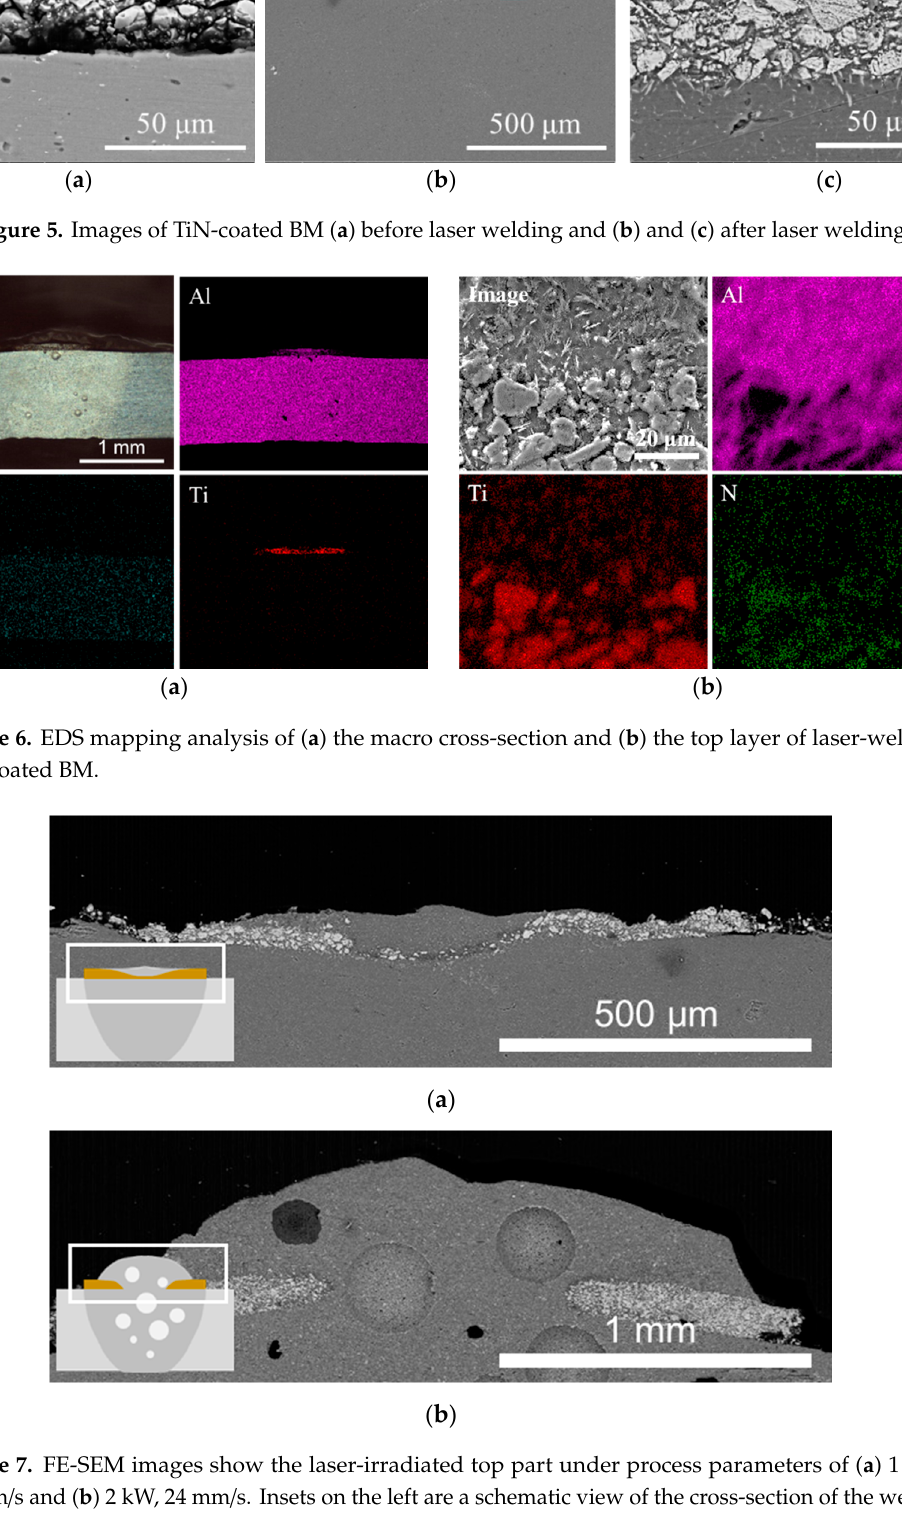
Figure 7. FE-SEM images show the laser-irradiated top part under process parameters of ( a ) 1 kW, 12 mm/s and ( b ) 2 kW, 24 mm/s. Insets on the left are a schematic view of the cross-section of the welds. Figure 7 shows two kinds of welds with the same heat input condition, but the scan speed and laser power are each times two. Since the energy distribution of the used laser shows a Gaussian function, the energy is concentrated at the center. More dissolution of MMC occurs in the central part than the side. The molten layer is solidified as the layer rises due to surface tension in the thinned or disappeared MMC layer region. Since TiN plays a crucial role in absorbing laser energy and